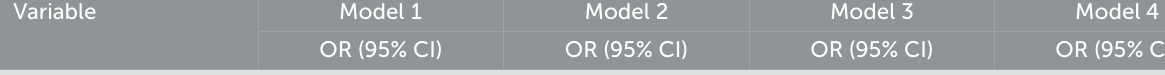
TABLE 3 The influence of social norms, positive outcome expectations, anti-smoking self-efficacy and attitudes toward control tobacco policies on adolescents’ smoking behavior (current smoking vs. non-smoking).